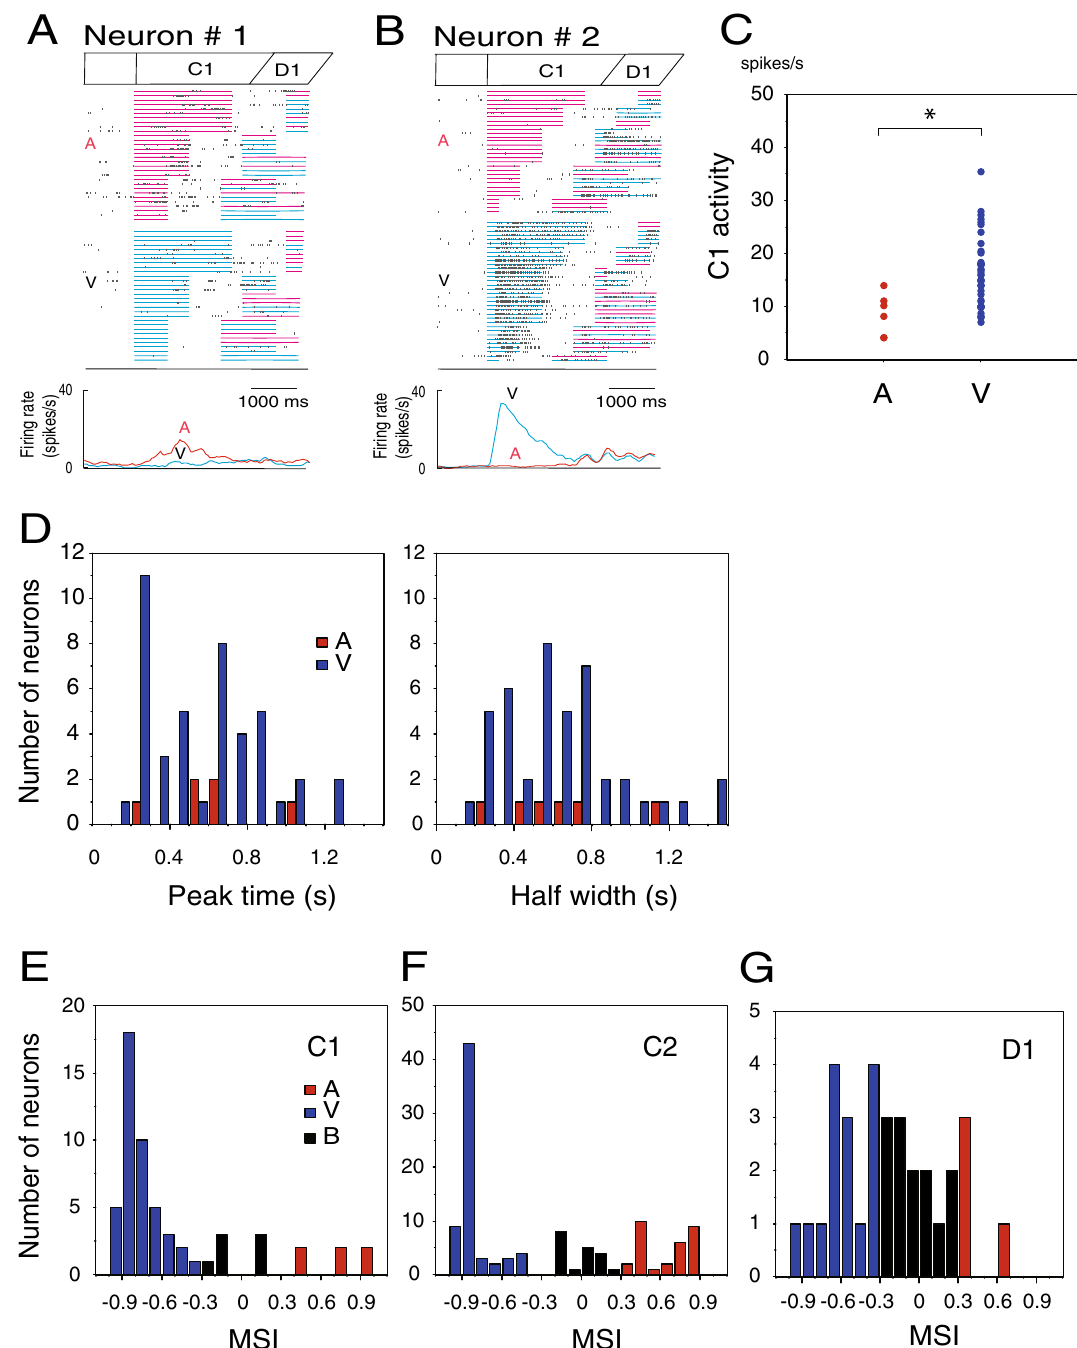
Figure 3. Activity of C1-responsive neurons. ( A ) An auditory C1-responsive neuron. A raster diagram and firing rate curves are aligned with C1 onset. In the raster display, which is separately shown in auditory (A) and visual (V) C1 trials and is rearranged by the C1 duration from long to short, a row corresponds to a trial. In each row, small black dots represent times of neuronal firing. Red and blue horizontal lines indicate auditory and visual cue presentations. For firing rate curves, firing rates were averaged in 200-ms sliding-time windows, moved in 40-ms steps, separately for auditory (red) and visual (blue) C1 trials. ( B ) A visual C1-responsive neuron. ( C ) Auditory and visual responses of the C1-responsive neurons. A scatter plot shows the mean firing rates of each auditory C1-responsive neuron (n = 6, red) during the auditory C1 period and those of each visual C1-responsive neuron (n = 43, blue) during the visual C1 period. A significant difference between the auditory and visual responses was detected ( p < 0.05) (shown by *). ( D ) Peak times and half widths of C1 activity. Distributions of peak times from C1 onset (left) and half widths (right) are displayed for the auditory responses (red bars) of auditory C1-responsive neurons and the visual responses (blue bars) of visual C1-responsive neurons. ( E ) Distribution of the modality sensitivity index (MSI) for the C1-responsive neurons. MSI = (AUD − VIS)/(AUD + VIS). AUD is the mean firing rate during auditory C1 presentation and VIS is the mean firing rate during visual C1 presentation. A neuron was defined as auditory (red bars) when the MSI was greater than 0.3, and as visual (blue bars) when the MSI was less than − 0.3; otherwise, it was defined as bimodal (B, black bars). ( F ) Distribution of the MSI for the C2-responsive neurons. ( G ) Distribution of the MSI for the D1-responsive